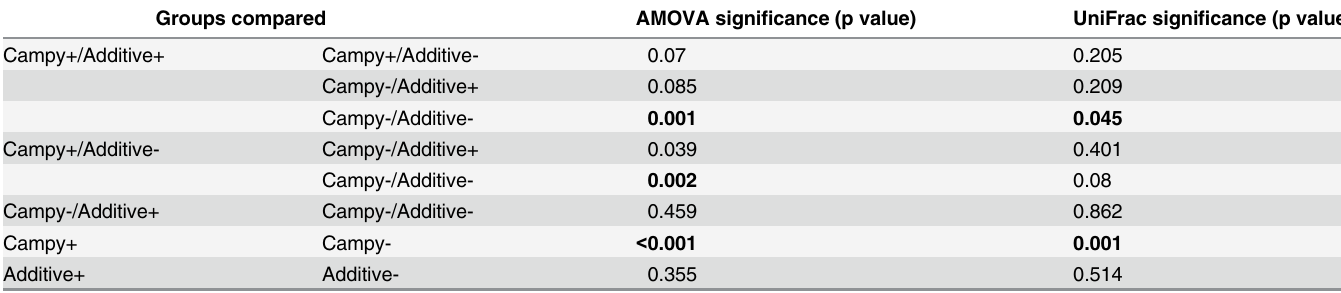
Table 2. Beta-diversity analysis across chicken groups and according to C . jejuni colonization or feed additive use. Groups compared